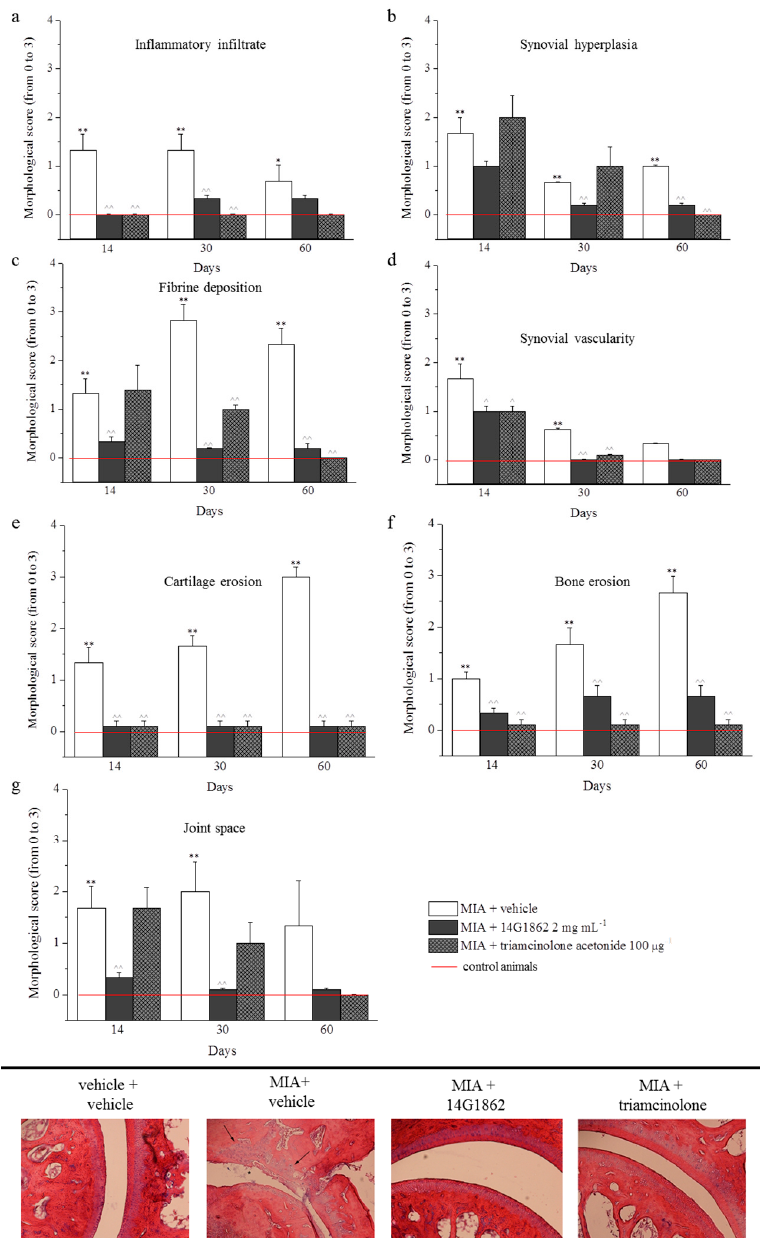
Figure 4. Morphological evaluations on tibio-tarsal joints. The upper panel (from a to g ) represents the quantification of morphological parameters by specific score (0: absent; 1: light; 2: moderate; 3: severe). Control animals had all morphological score equal to 0 and were indicated in graphs by